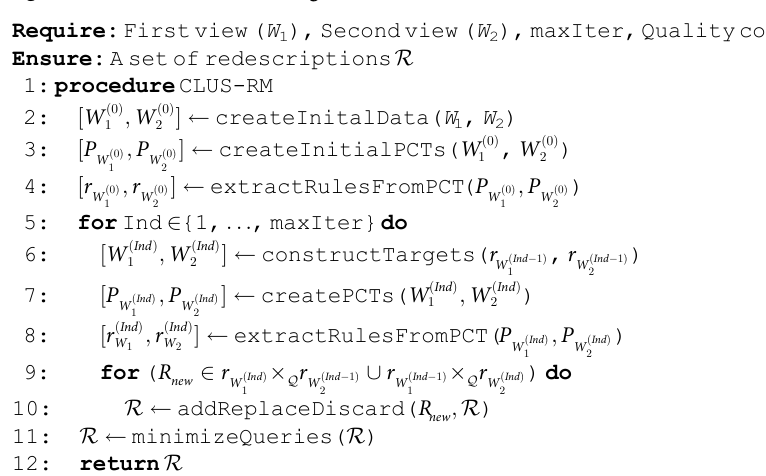
Algorithm 1 The CLUS-RM